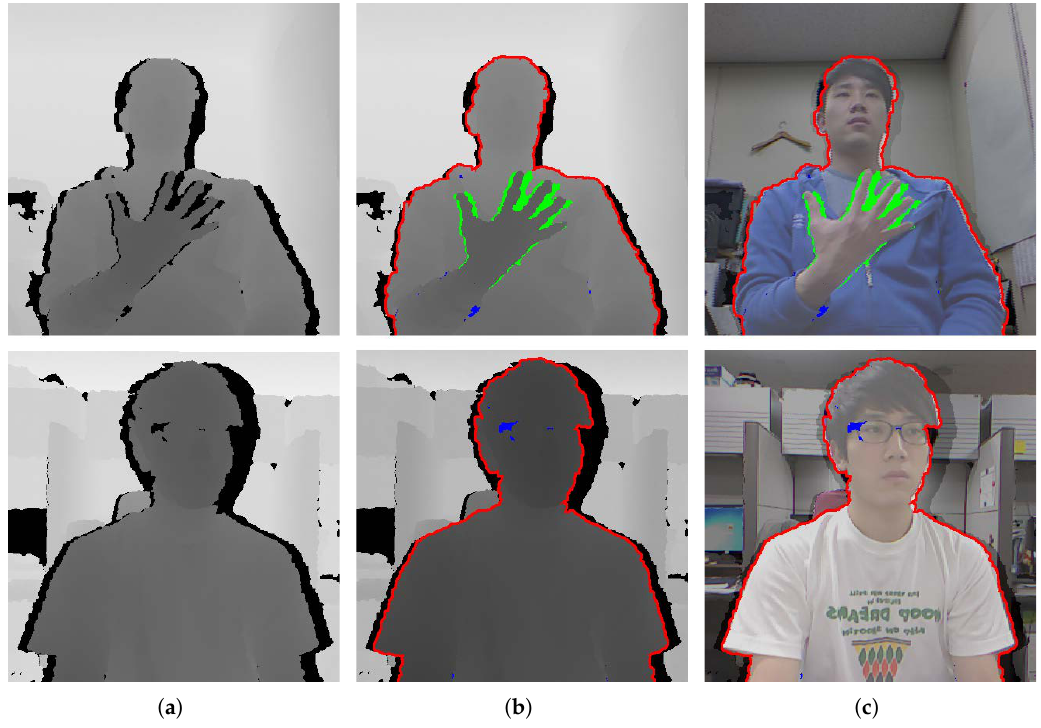
Figure 1. ( a ) The initial depth image; ( b ) the depth image with a colored marker; ( c ) the depth image overlaid with the color image with a colored marker. (The depth images are normalized and aligned with the color images. Blue, green and red markers indicate the first, second and third cases introduced in Section 2, respectively, and the black regions represent missing depth